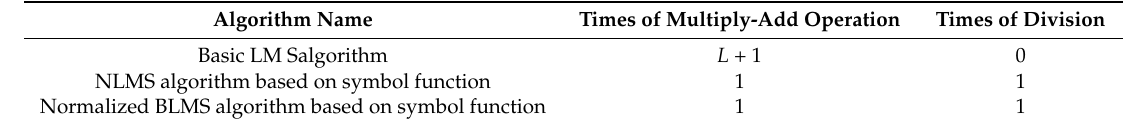
Table 1. Comparison of complexity of three kinds of adaptive algorithms.